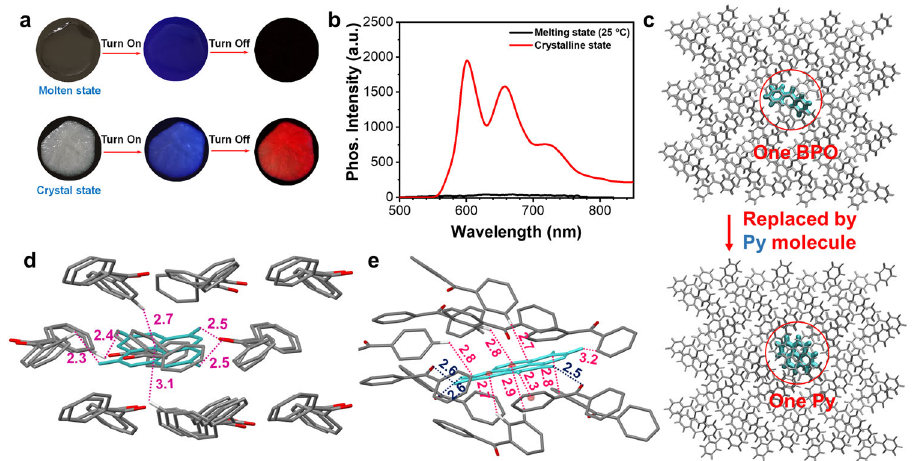
Fig. 3 Non-radiative suppression of guest excitons by host matrix. a Photographs of Py/BPO in different states. b Phosphorescence spectra of Py/BPO . Excitation wavelength: 380 nm; Delayed time: 1 ms. c Model setup of Py/BPO guest – host system. d Spatial distances between the Py molecule and the surrounding BPO molecules. e Interaction distances of C-H--- π or C-H---O interactions between Py molecule and surrounding BPO molecules. The distances between each phenyl ring center of Py molecule and the hydrogen atom of the BPO molecules are marked by a red line. The corresponding distances between the oxygen atom of BPO and the hydrogen atoms of Py are marked by a blue line.